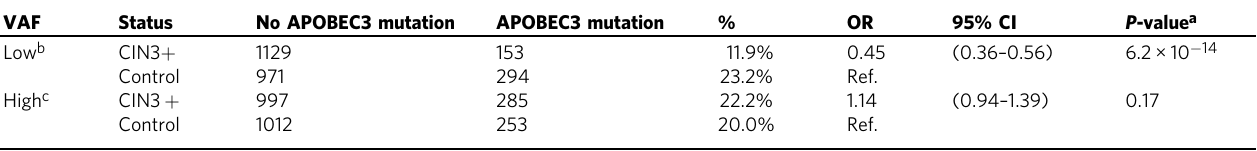
Table 2 Cases and controls with and without APOBEC3-induced mutations by variant allele fraction in the NCI-Kaiser PaP cohort.